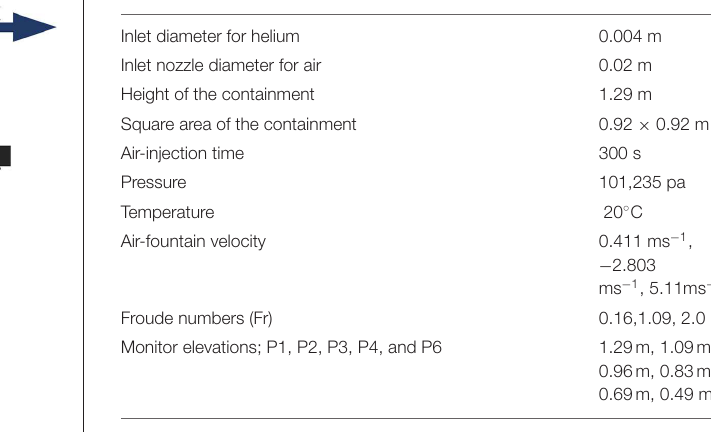
TABLE 1 | Design parameters of the